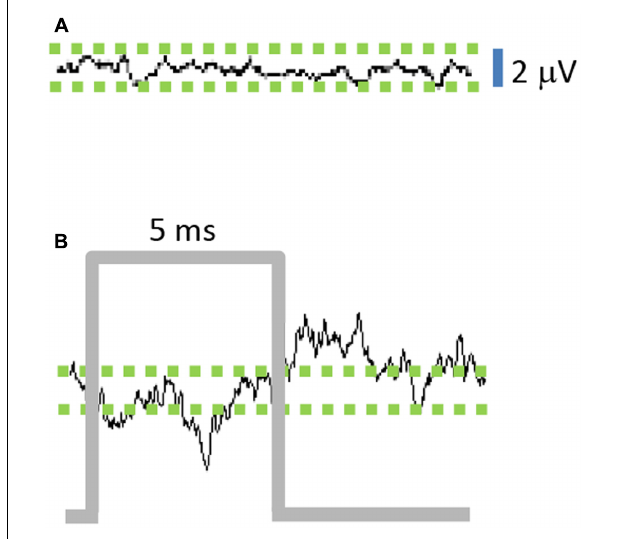
FIGURE 3 | Stimulation of M1-STN projections modulates local field potential (LFP) amplitude. (A) Average of 10 ms epochs of STN-LFPs in absence of stimulation results in small residual signal due to random variations between epochs, while (B) Stimulus-triggered average of 10 ms epochs